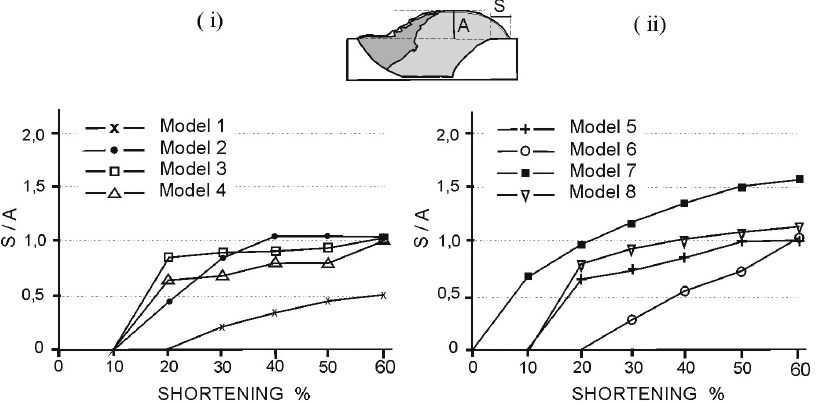
Fig. 8 – Ratio of backward displacement on backstop flat (S) vs. anticlinal amplitude (A) (see inset cross-section) plotted against shortening (%) for the inversion experiments with (i) a convex-up mobile backstop and (ii) a concave-up mobile backstop. The convex-up mobile backstop model 1 ( α and β = 60 ◦ ) and the concave-up mobile backstop model 7 produce the smallest and biggest S/A ratio, respectively (see text for explanation).